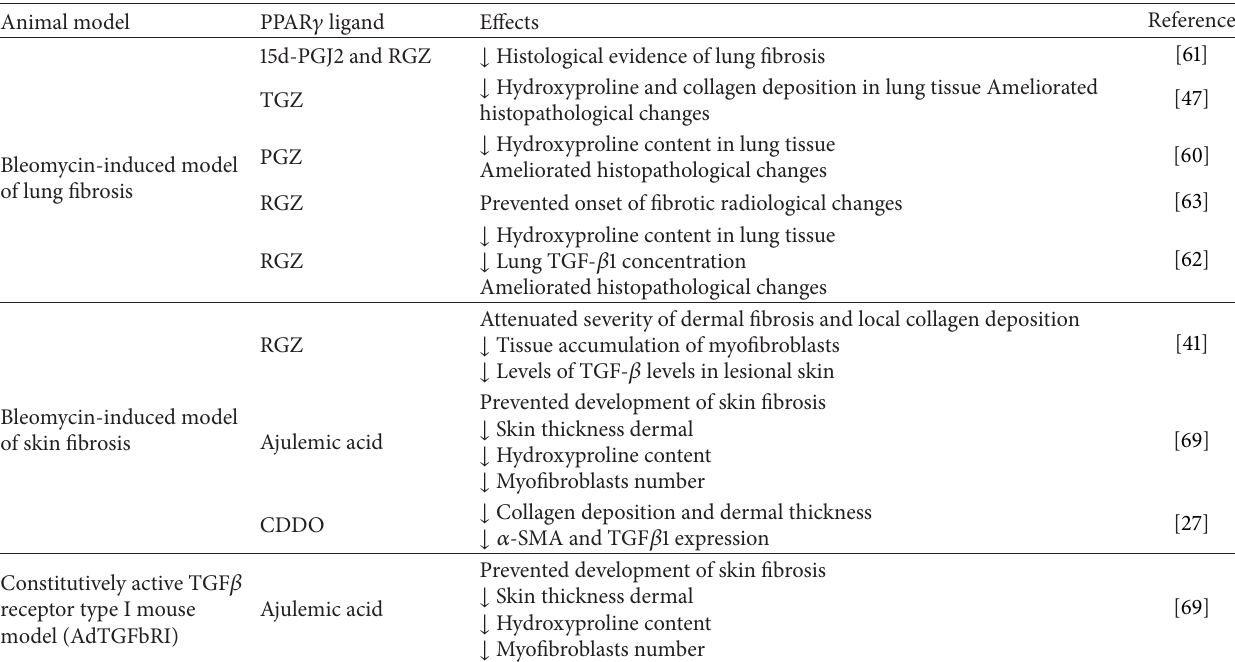
Table 2: In vivo studies of antifibrotic effects of PPAR 𝛾 agonists.